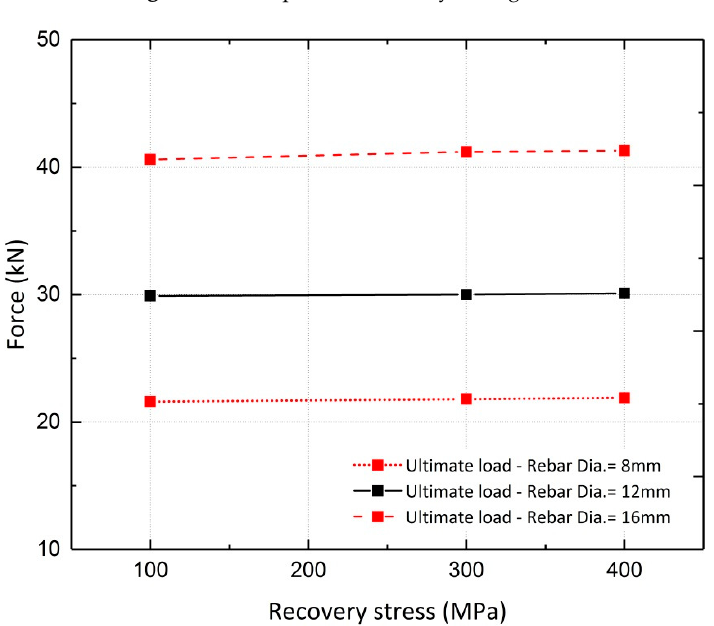
Figure 26. Comparison of ultimate loads.